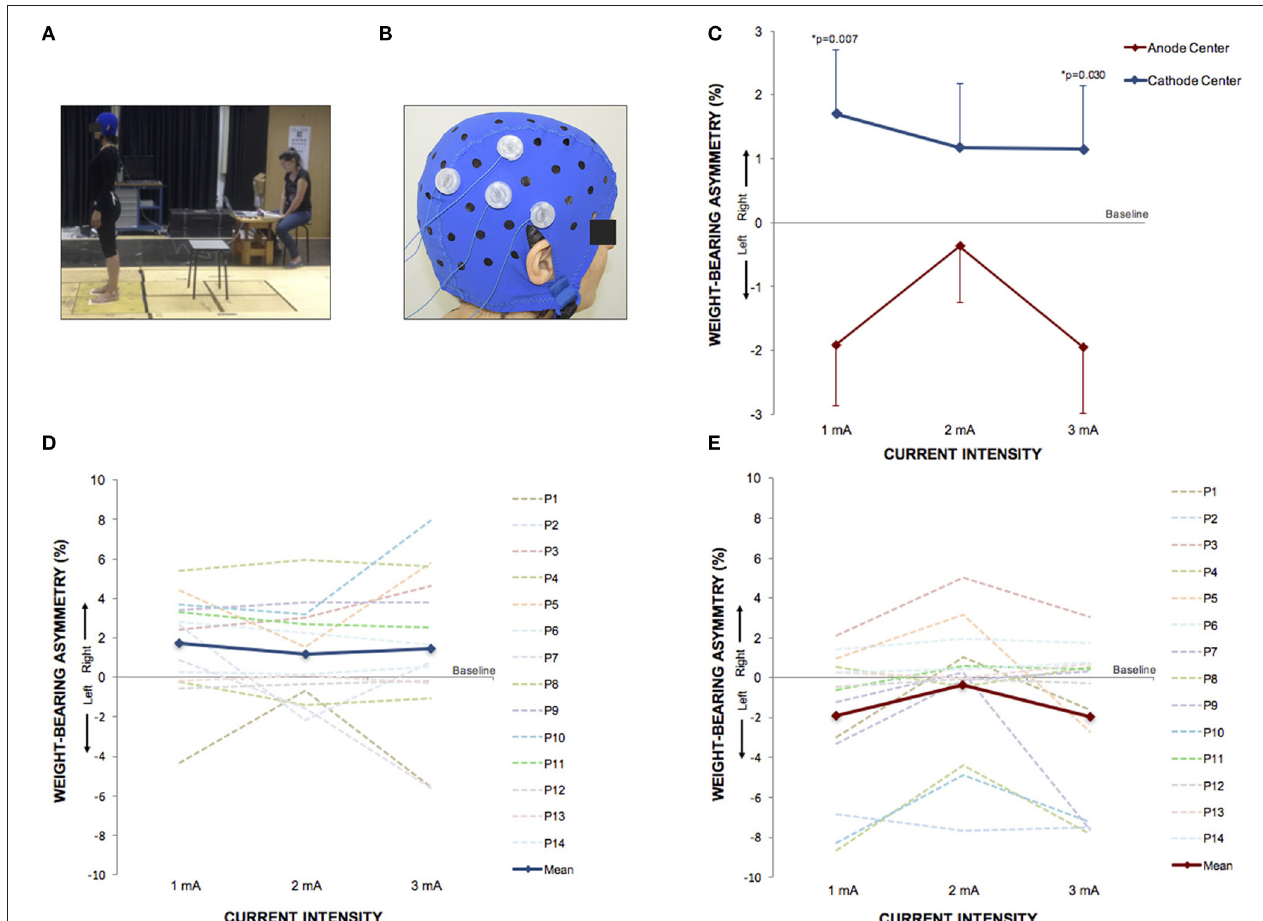
FIGURE 5 | HD-tDCS 3 × 1 over the right temporo-parietal junction can produce postural asymmetry. (A) Experimental set up of the postural control trial. (B) Position of the HD-tDCS 3 × 1 electrodes in a female participant. (C) Difference between the WBA assessed at baseline and at current intensities of 1, 2, and 3mA (mean; s.e.m). There were polarity-dependent effects that produced a rightward WBA after cathode center and leftward WBA after the anode center condition. (D) Difference between the WBA assessed at baseline and at current intensities of 1, 2, and 3mA after cathode center HD-tDCS 3 × 1 condition of each participant showing the variability of the data and overall effects toward the right side (mean; s.e.m.). (E) Difference between the WBA assessed at baseline and at current intensities of 1, 2, and 3mA after anode center HD-tDCS 3 × 1 condition of each participant showing the wide range of the data and overall effects toward the left side. Written informed consent was obtained from the participants for the publication of this image.